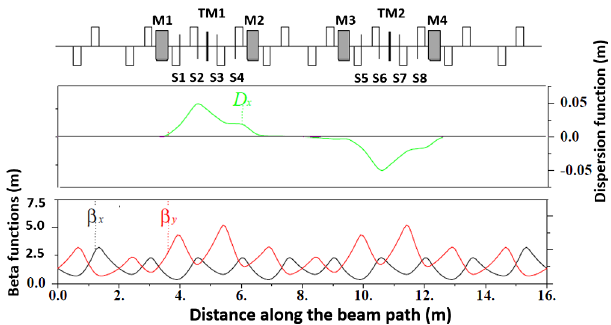
FIG. 7. This plot shows horizontal β x and vertical β y Twiss functions in the bottom panel, dispersion function D x in the middle panel, and a sequence of magnetic elements at the top. The open rectangles are the quadrupoles, the grey rectangles are bending magnets, and the two narrow black rectangles are trim